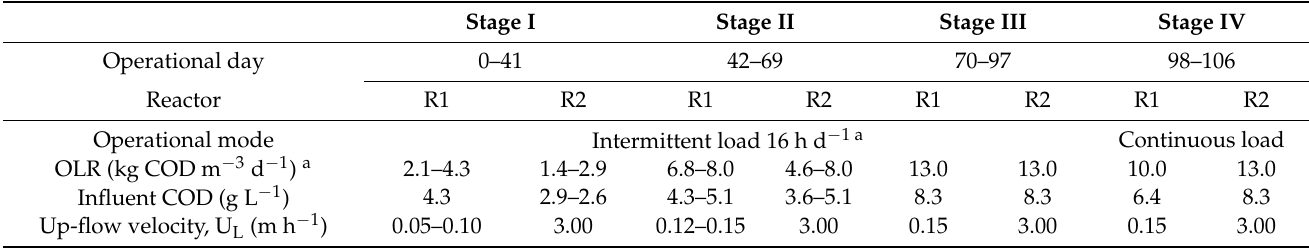
Table 1. Operational schedule of the anaerobic sludge bed